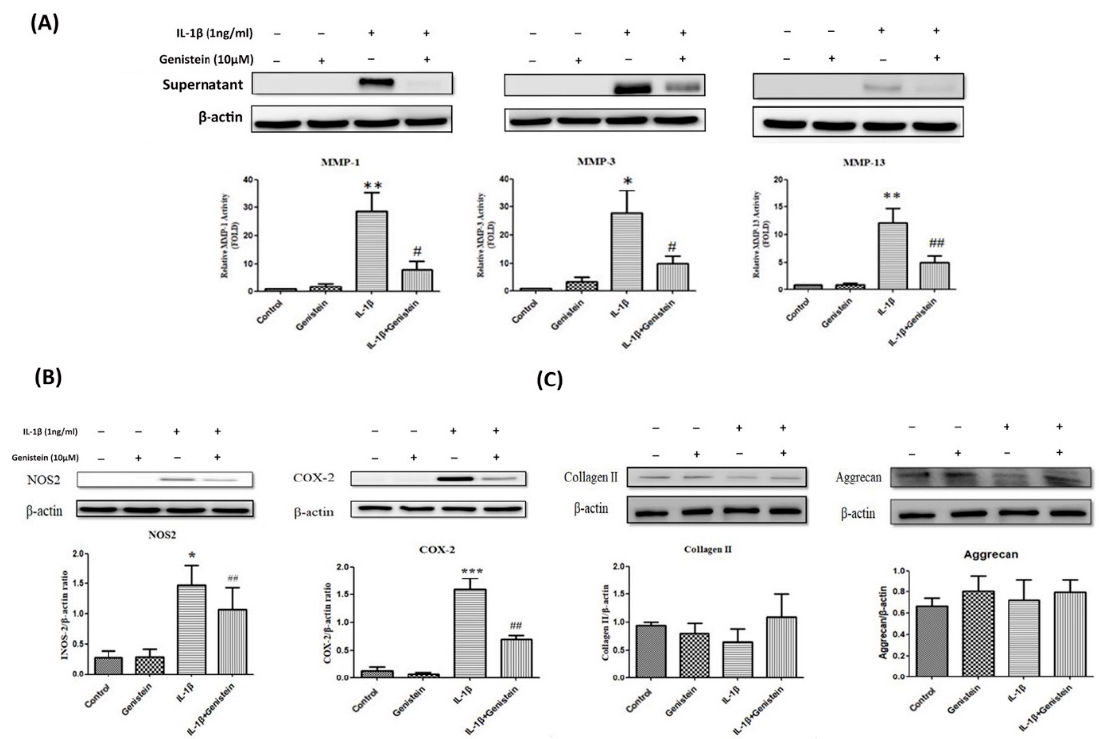
Figure 2. E ff ects of genistein on protein expression levels of MMP-1, MMP-3, MMP-13, NOS2, COX-2, aggrecan, and collagen II in IL-1 β -induced human chondrocytes. ( A–C ) Human chondrocytes were stimulated using IL-1 β and then treated with genistein for 24 h. The expression of MMP-1, MMP-3, MMP-13, NOS2, COX-2, aggrecan and collagen II was quantified using Image J software. Results are presented as the mean ± SD from at least three independent experiments. Significance was determined using a t-test. Significant di ff erences between the genistein group and the control group are indicated by an asterix (*); significant di ff erences between the genistein group and the IL-1 β group are indicated by a pound symbol (#). *, # p < 0.05; **, ## p < 0.01; *** p < 0.001.